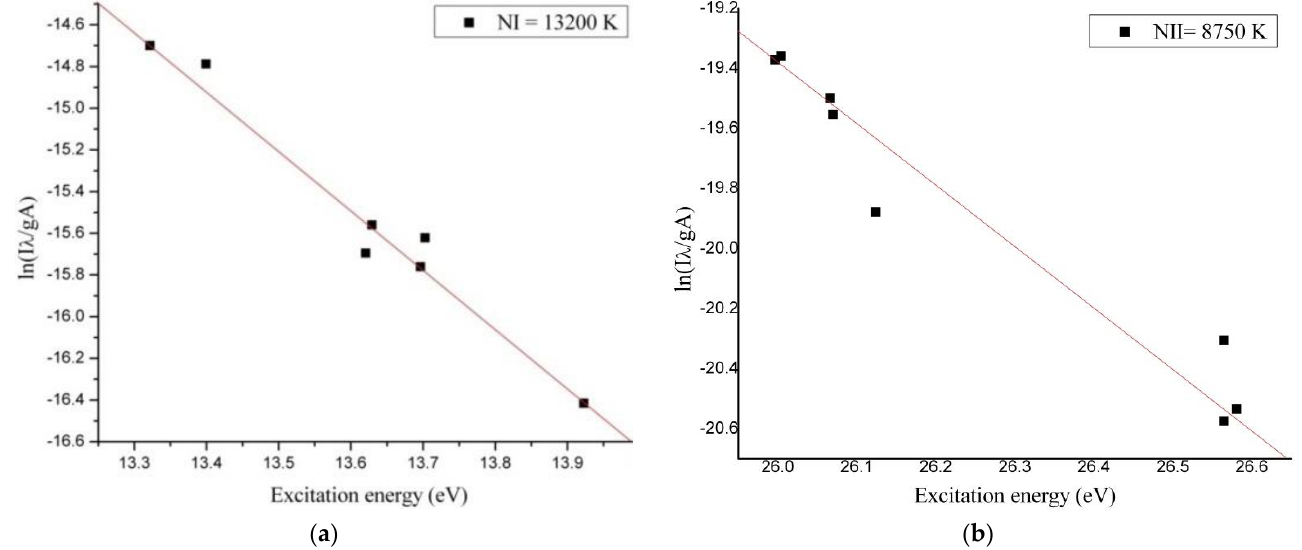
Figure 6. Boltzmann Plot for ( a ) NI in the air at normal pressure and ( b ) for NII in air at normal pressure.